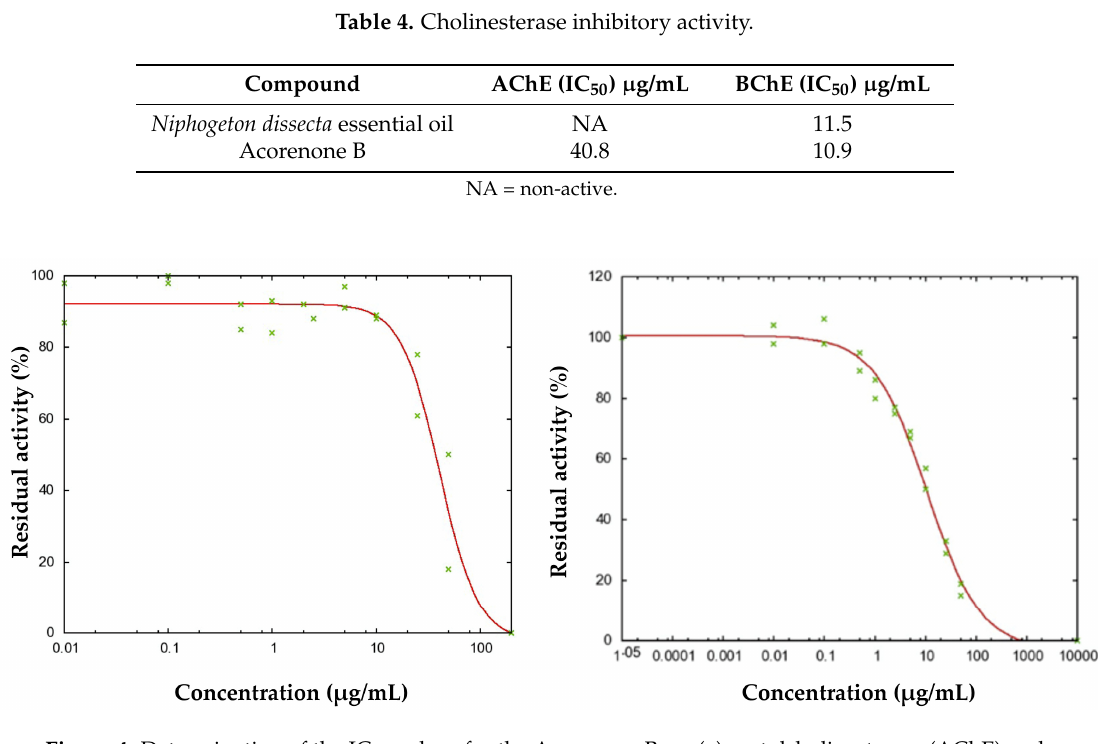
Figure 4. Determination of the IC 50 values for the Acorenone B vs. ( a ) acetylcholinesterase (AChE) and ( b ) butyrylcholinesterase (BChE). IC 50 : half maximal inhibitory